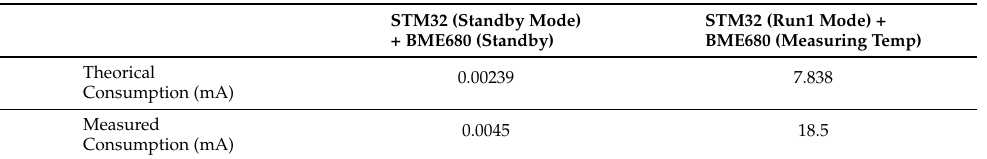
Table 6. Comparison of theoretical and measured power consumption values on the node/sensor (STM32 +